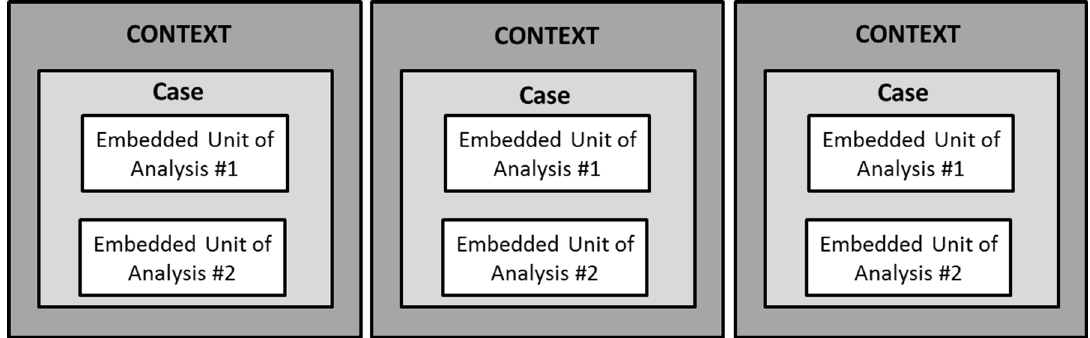
Figure 1: Multiple case study design with embedded units of analysis (modified from